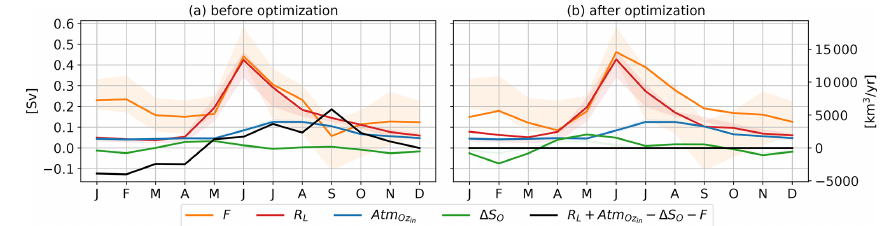
Figure 13. 1993–2018 adjusted mean annual cycles of atmospheric and terrestrial freshwater fluxes in the Arctic hydrological cycle as well as oceanic volume transports and storage changes before (a) and after (b) the optimization. Shading represents the uncertainties of the a priori estimates (shown in both plots). The black line shows the sum of all budget terms, and by going to zero, it demonstrates the closure of the monthly budgets after the